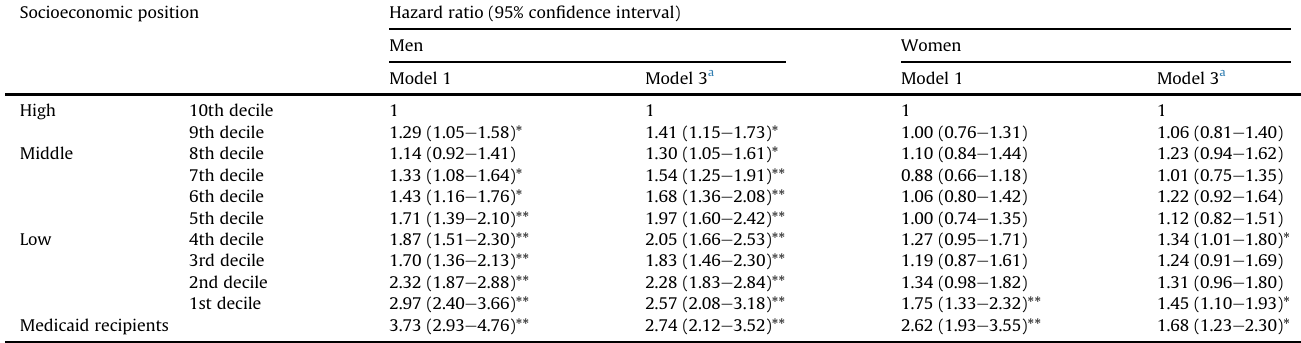
Table 4 Hazard ratios across socioeconomic positions, strati fi ed by gender. Socioeconomic position